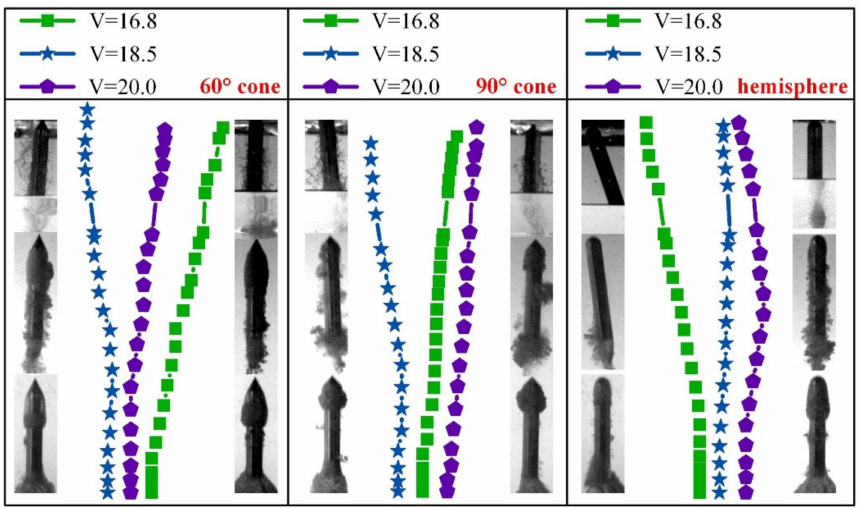
Figure 13. Trajectory curve of the projectiles under three head forms and launch speeds.